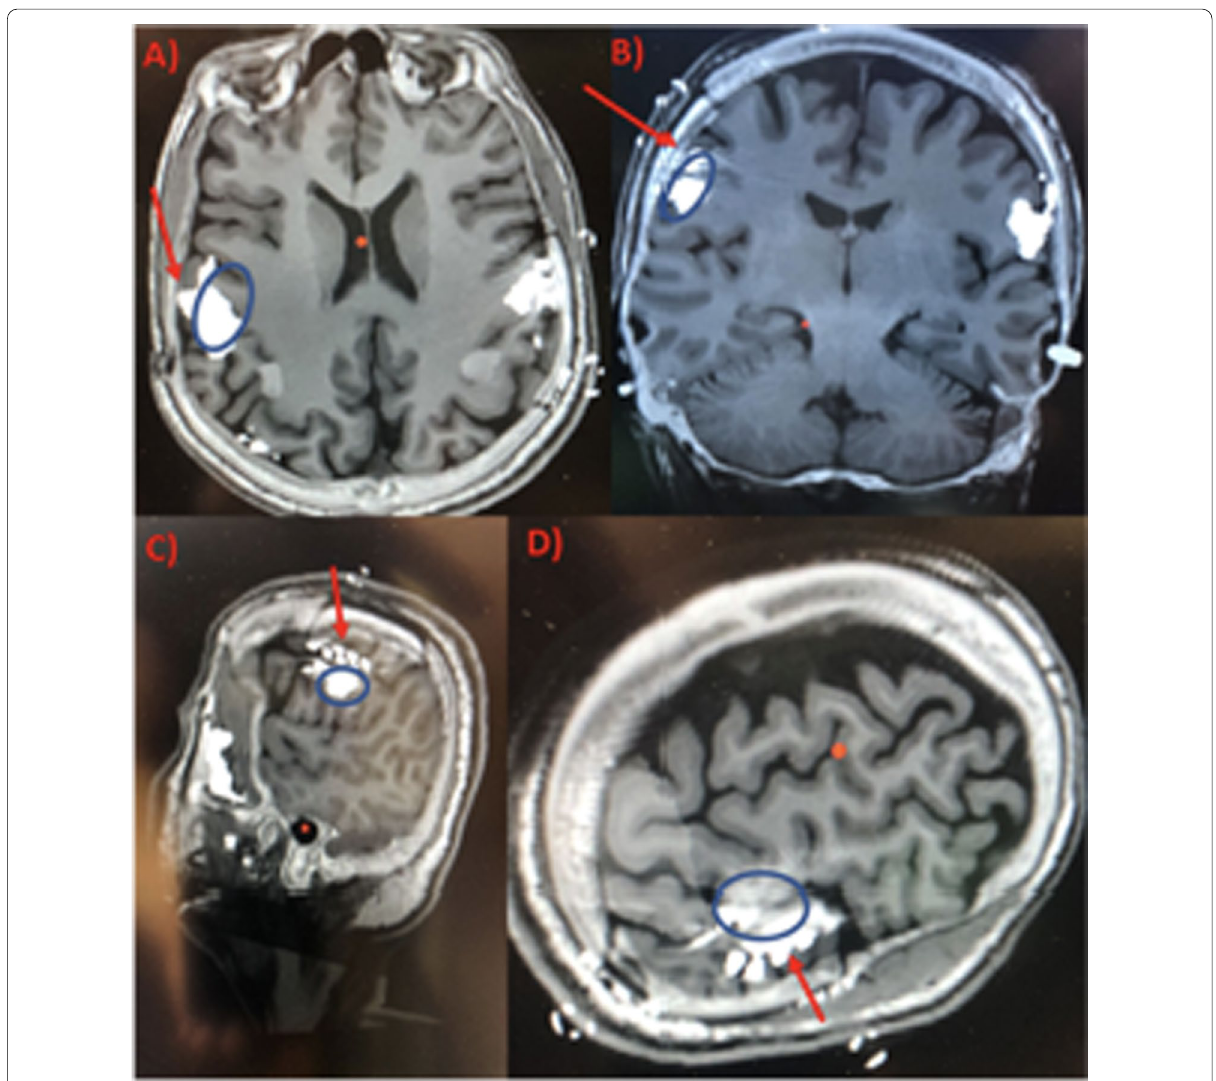
Fig. 3 Postoperative CT overlay with preoperative fMRI. Red arrow is grid, blue circle is tongue functional motor cortex: A axial, B coronal, C sagittal, D